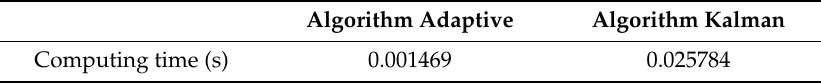
Table 4. Average computing times for di ff erent